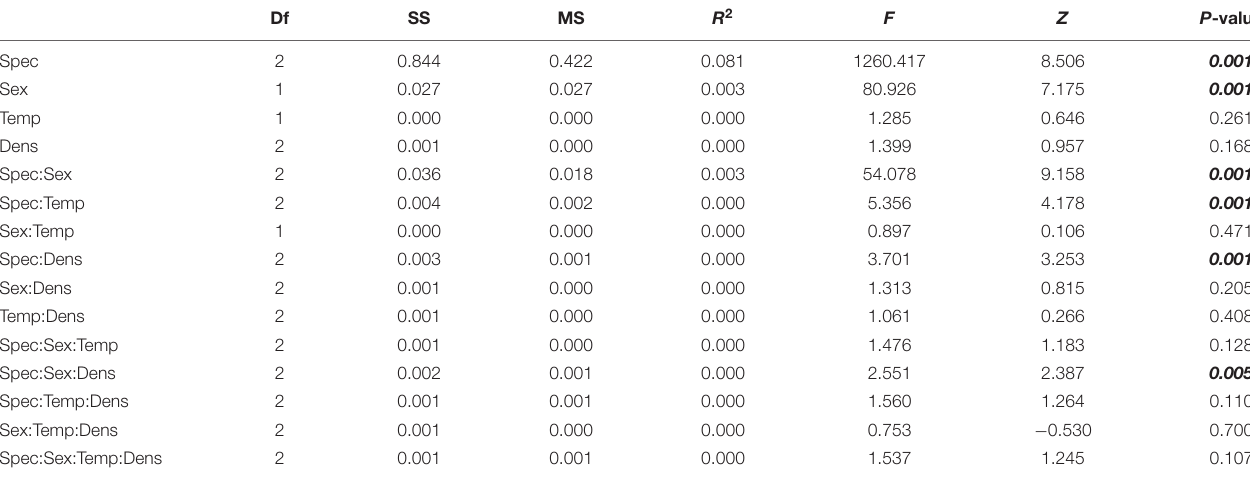
TABLE 1 | Effects of species, sex, temperature, density, and their interactions on total wing shape tested by Type III Procrustes ANOVA. Df SS MS R 2 F Z P -value